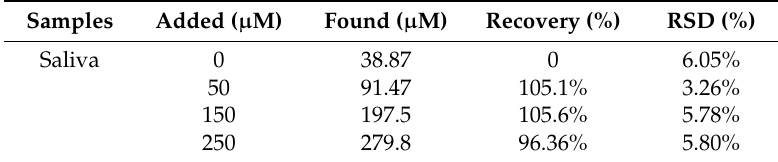
Table 1. Detection of glucose in real samples by using the CuO/PCL@PPy/ITO electrode.